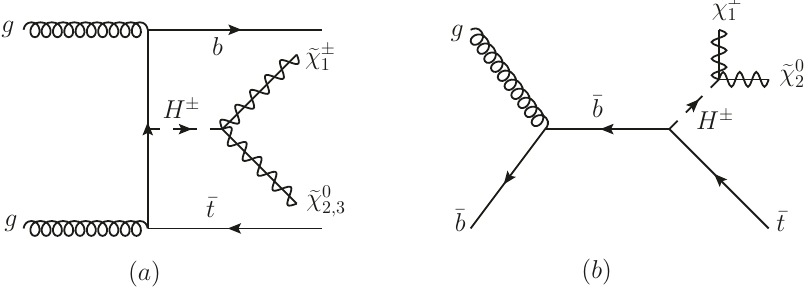
Figure 23. The Feynman diagram of (a) 4 F and (b) 5 F charged Higgs production at LO, which decays to electroweakinos yielding LLCP signature at the